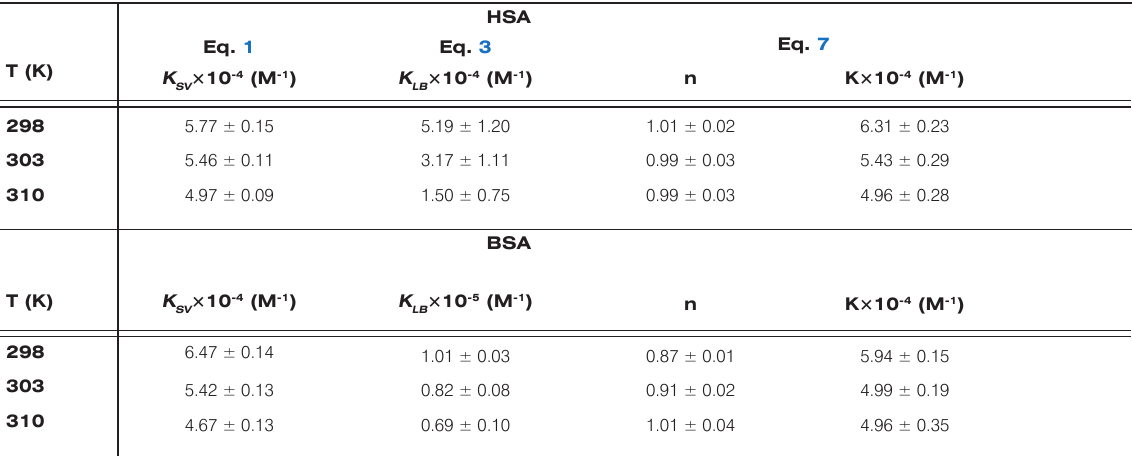
Figure 6. Fitting plot to Eq. 7 of A) HSA–(I) system ([HSA] = 0.75×10 -6 M; λ (310 K); B) BSA–(I) system ([BSA] = 0.75×10 -6 M; λ different